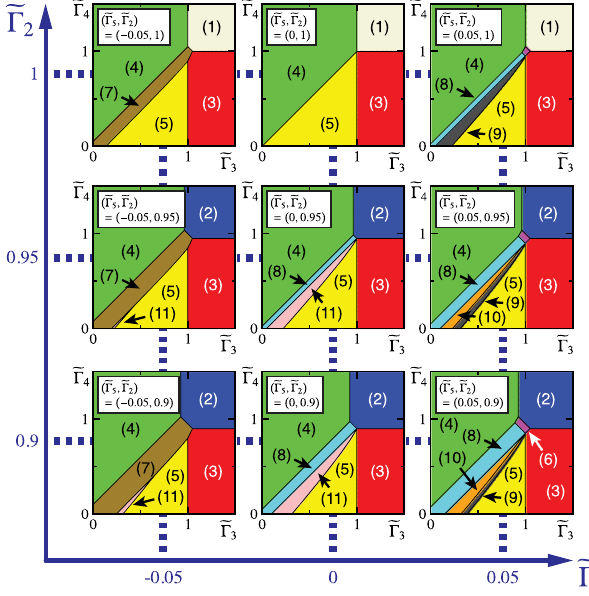
e Γ ≡ Γ Γ Γ 0 ν ν = 1 with 1 >